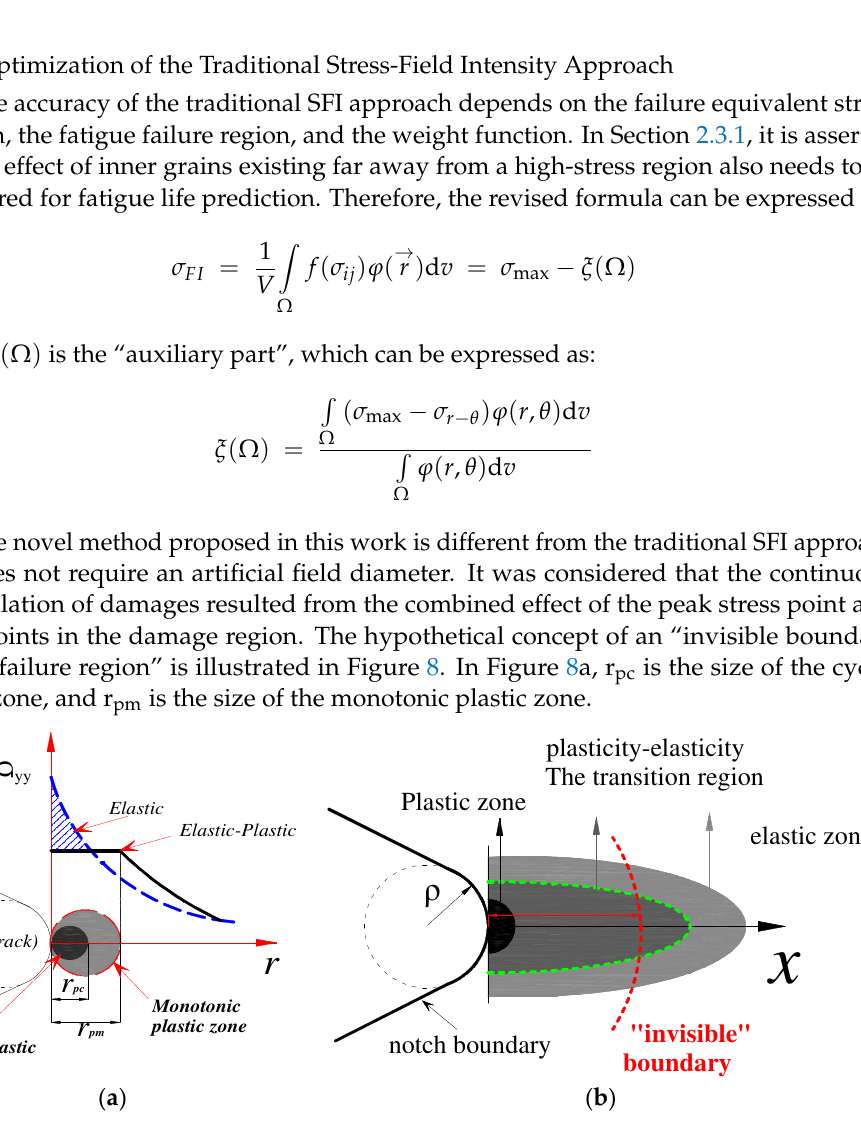
Figure 8. Schematic diagram of the novel elastic–plastic zone at the crack tip (notch): ( a ) monotonic plastic zone and cyclic plastic zone ( b ) invisible boundary region.